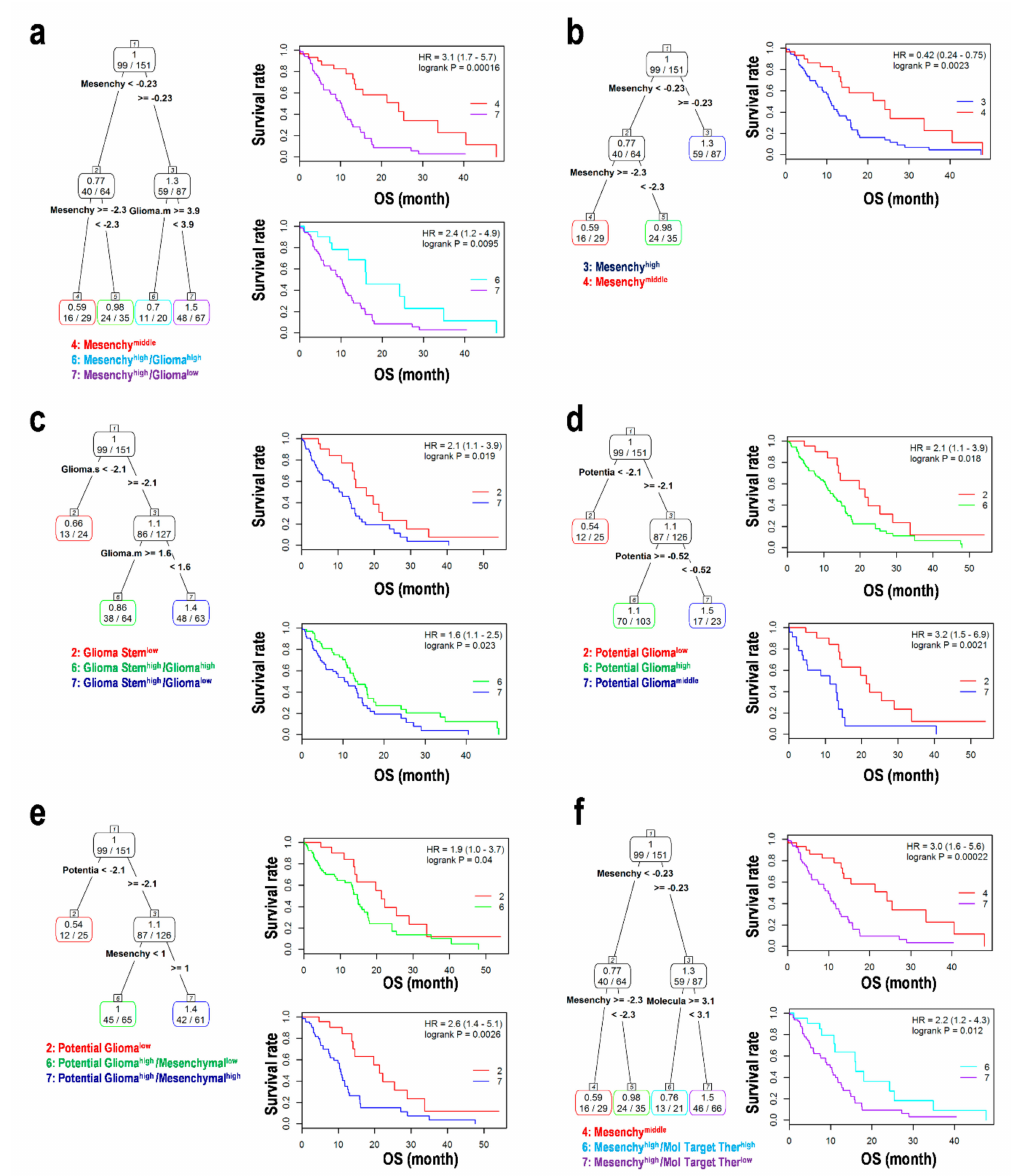
Figure 5. Survival tree analysis for the epithelial–mesenchymal transition (EMT) statuses and glioma markers in glioblastoma. ( a ) Mesenchymal status and glioma markers. ( b ) Mesenchymal status. ( c ) Glioma stem cell markers and glioma markers. ( d ) Potential glioma biomarkers. ( e ) Potential glioma biomarkers and mesenchymal status. ( f ) Mesenchymal status and molecular target therapy genes. HR; hazard ratio, OS; overall